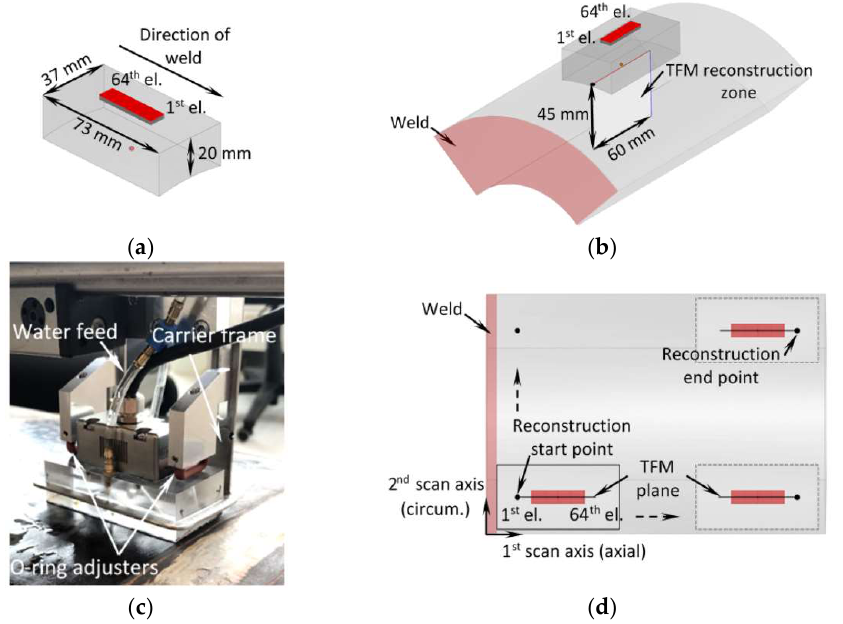
Figure 3. ( a ) Array positioning and dimensions of the wedge; ( b ) array positioning on pipe segment and dimensions of TFM reconstruction zone; ( c ) phased array holder in the experimental stand; ( d ) scanning sequence. Table 3. The phased array, wedge, pulser, scanner and reconstruction parameters used in the ex- periments.